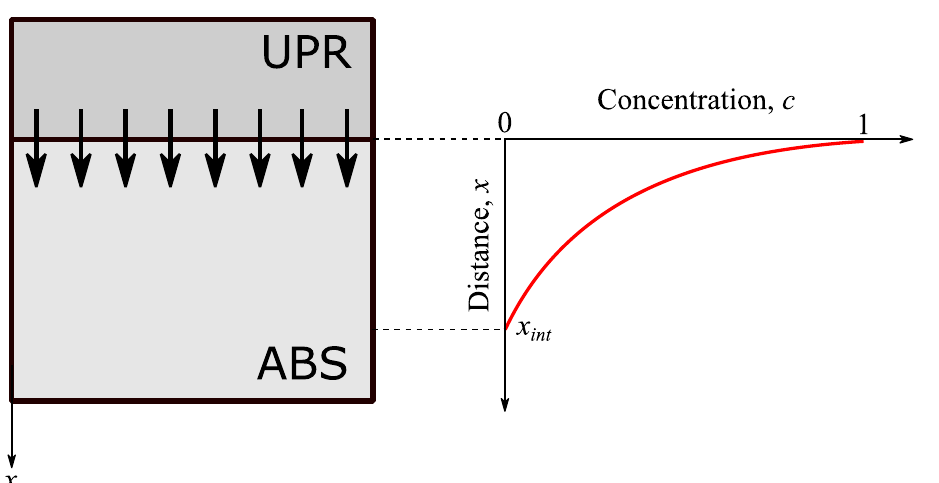
Figure 3. Schematic view of the 1D diffusion of UPR into ABS (left). The resulting concentration distribution (right).